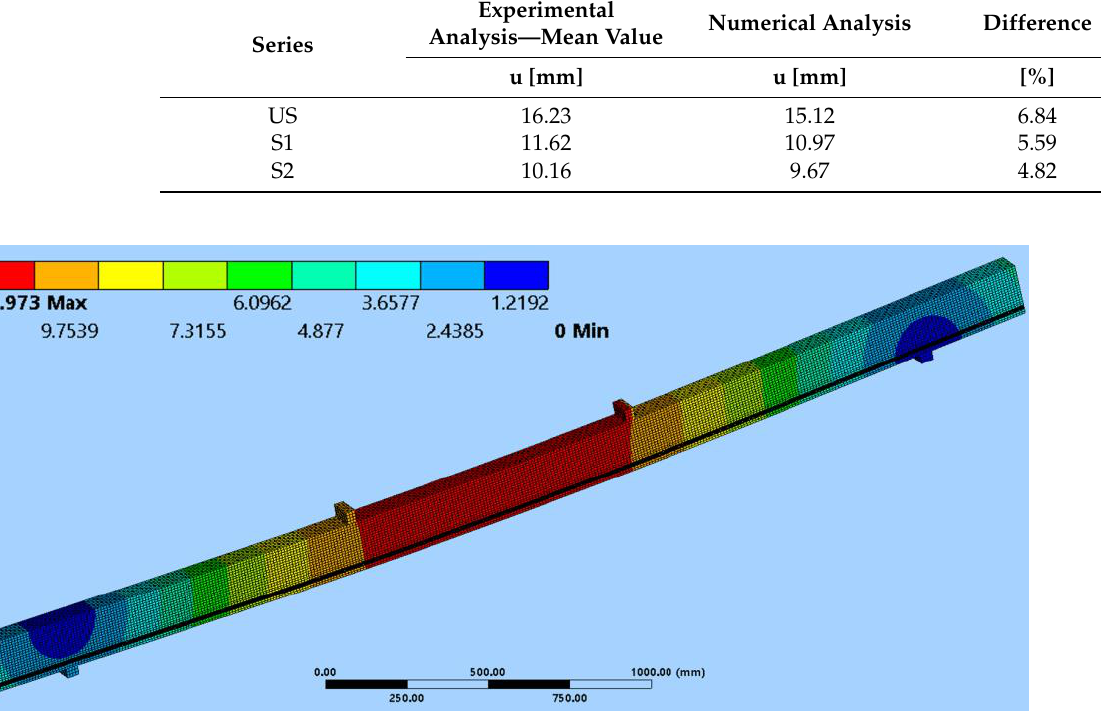
Figure 8. The deflection distribution for the S1 beam series.